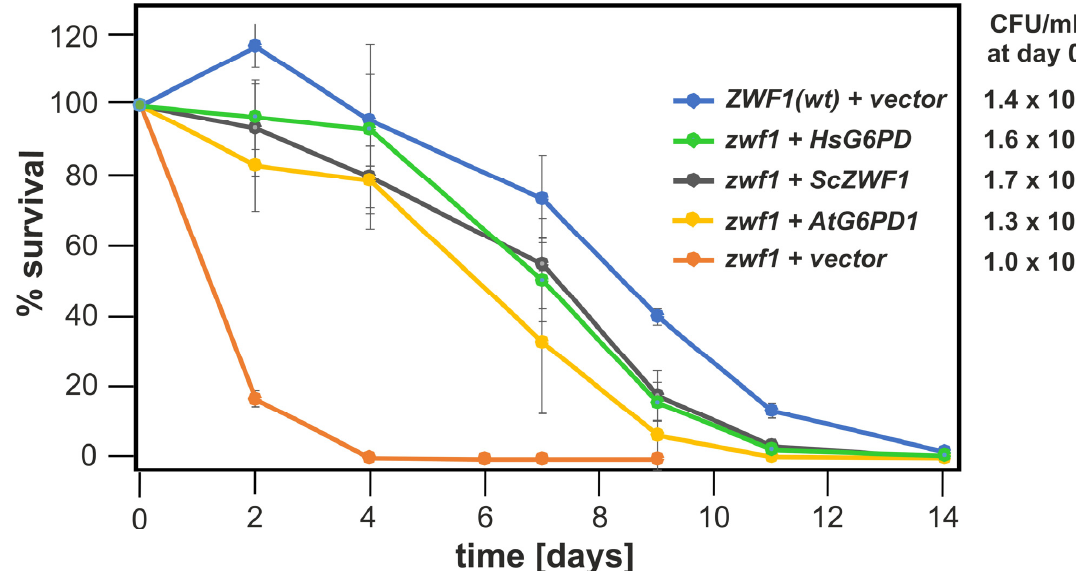
Figure 5. Chronological lifespan of a yeast zwf1 deletion expressing heterologous G6PD genes. The indicated plasmids were introduced into strain HOD269-1C ( zwf1::kanMX ) and cultures were grown to stationary phase in synthetic selective medium. Samples were taken at the time points indicated, appropriately diluted to produce single colonies, plated on rich medium and incubated for three days prior to determination of colony-forming units (CFU). CFUs were set at 100% at day 0, with starting counts indicated at the upper-right corner, and relative viability was determined in three independent cultures, each. Error bars give the standard deviations of % survivors in these three biological